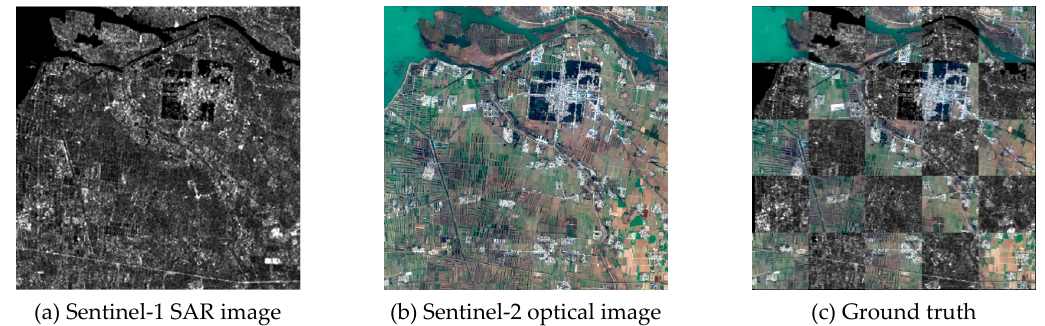
Figure 5. The original simulated data and the ground truth for the Sentinel-1 and Sentinel-2 images.